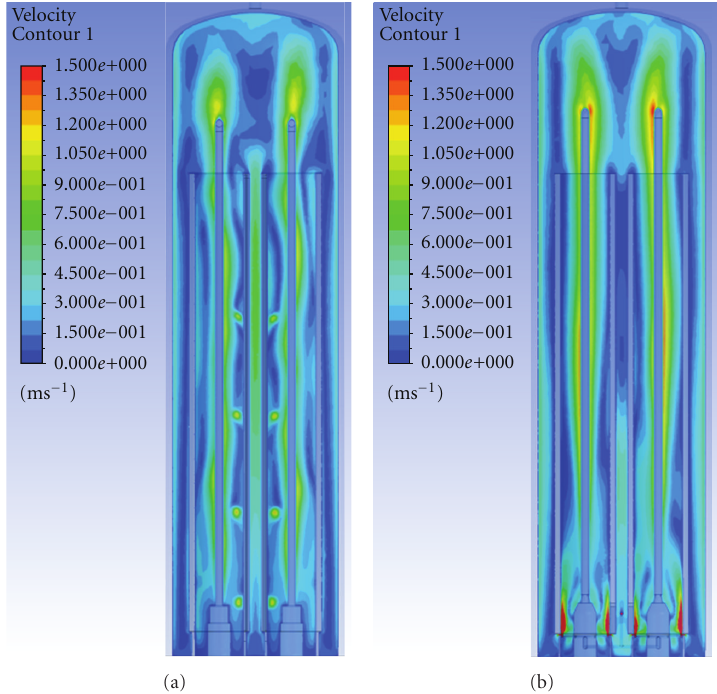
Figure 5: Simulation analysis results of fluid velocity between nozzle (a) type A and (b) B.